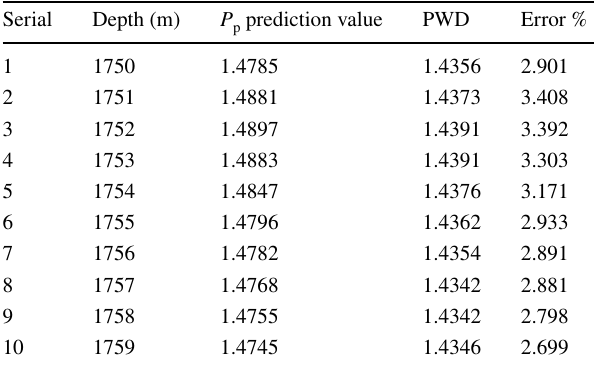
Table 6 The error between formation pressure prediction value and monitoring